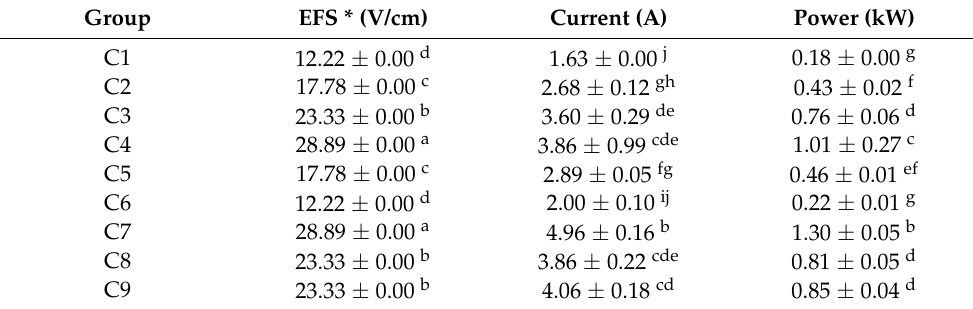
Figure 2. Comparisons of come-up time ( a ) and response graph of lower-better ( b ) and heating rate ( c ), as well as the values with higher-better ( d ) signal-to-noise ratios of different conditions in ohmic heating treatments. Values C1–C16 represent pineapple cores in different treatment conditions including temperature (°C), time (min), voltage (V), and frequency (Hz), respectively: 1: 70, 15, 110, and 60; 2: 70, 30, 160, and 340; 3: 70, 45, 210, and 620; 4: 70, 60, 260, and 900; 5: 80, 15, 160, and 620; 6: 80, 30, 110, and 900; 7: 80, 45, 260, and 60; 8: 80, 60, 210, and 340; 9: 90, 15, 210, and 900; 10: 90, 30, 260, and 620; 11: 90, 45, 110, and 340; 12: 90, 60, 160, and 60; 13: 100, 15, 260, and 340; 14: 100, 30, 210, and 60; 15: 100, 45, 160, and 900; and 16: 100, 60, 110, and 620. The same letters show insignificant differences in the same rows ( p < 0.05). The results are reported as means ± SD. Table 2. Changes in electrical values at target temperatures in pineapple core extraction in various ohmic heating